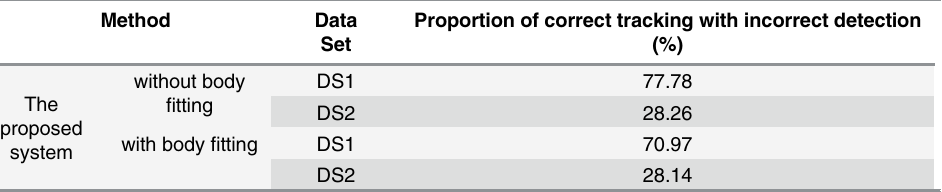
Table 8. Proportion of correct tracking with incorrect